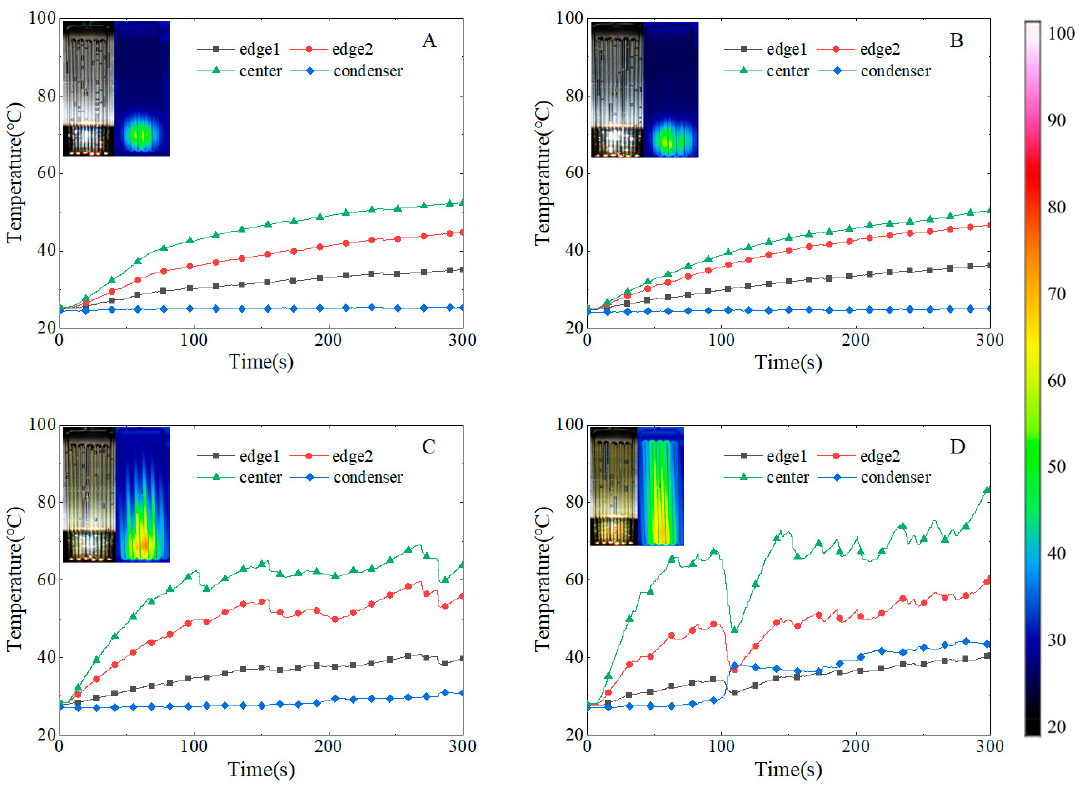
Figure 6. Temperature variations of the PHP with the filling ratio of 80%: ( A – D ) filling with DI water, 0.001 wt% AgNPs, 0.01 wt% AgNPs, and 0.02 wt% AgNPs nanofluid, respectively. The inset shows the photographs and infrared images 120 s after solar radiation.